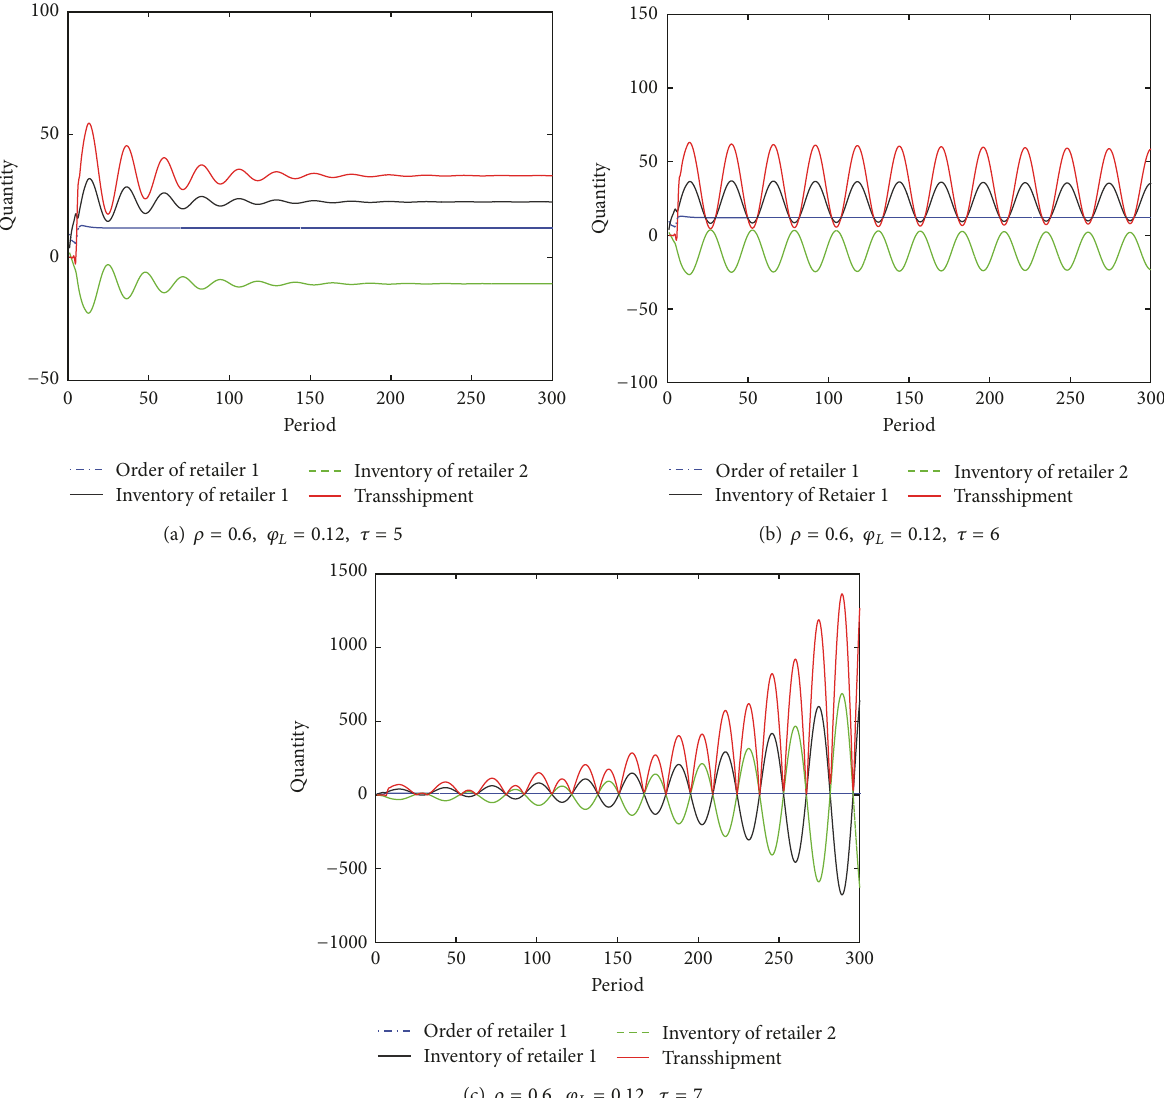
Figure 5: Stability validation for Theorem